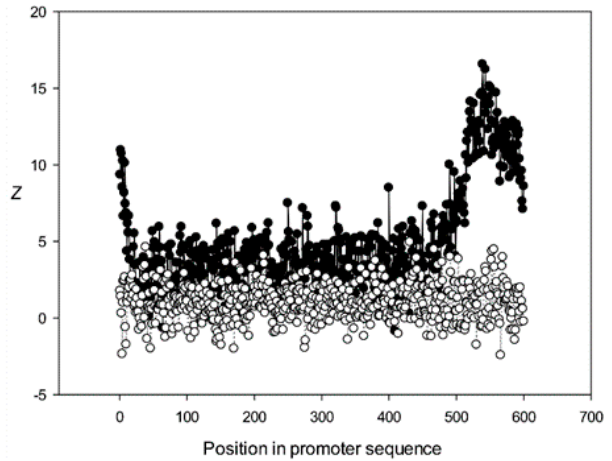
Figure 10. Dependence of Z on position l for promoter sequences of the second class. Black circles indicate multiple alignment for promoter sequences of the second class and white circles indicate randomly mixed promoter sequences where positions of indels were maintained.